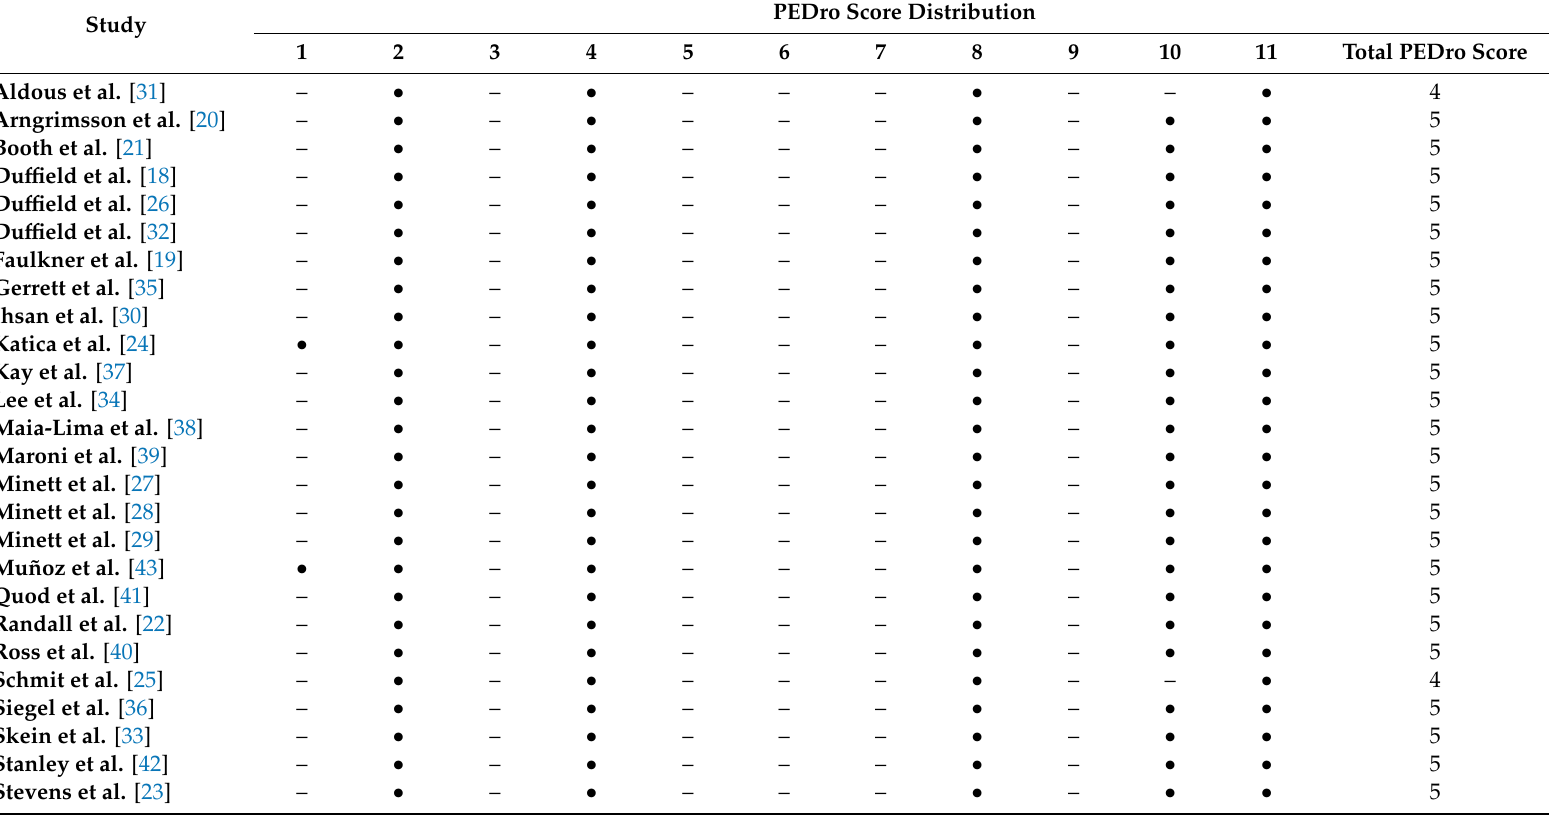
Table 2. Quality assessment of the included